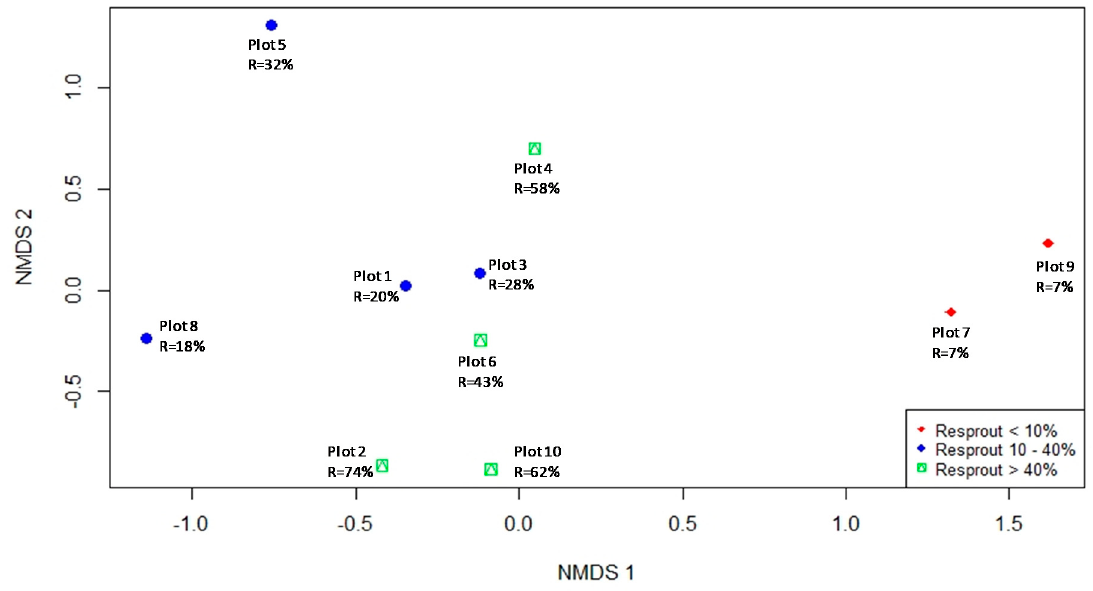
Figure 3. Results of the two-dimensional non-metric multidimensional scaling (NMDS). Resprouting groups are represented by colours: G1 (red), G2 (blue), G3 (green), and resprouting percentages are shown under each plot label.4. Discussion.